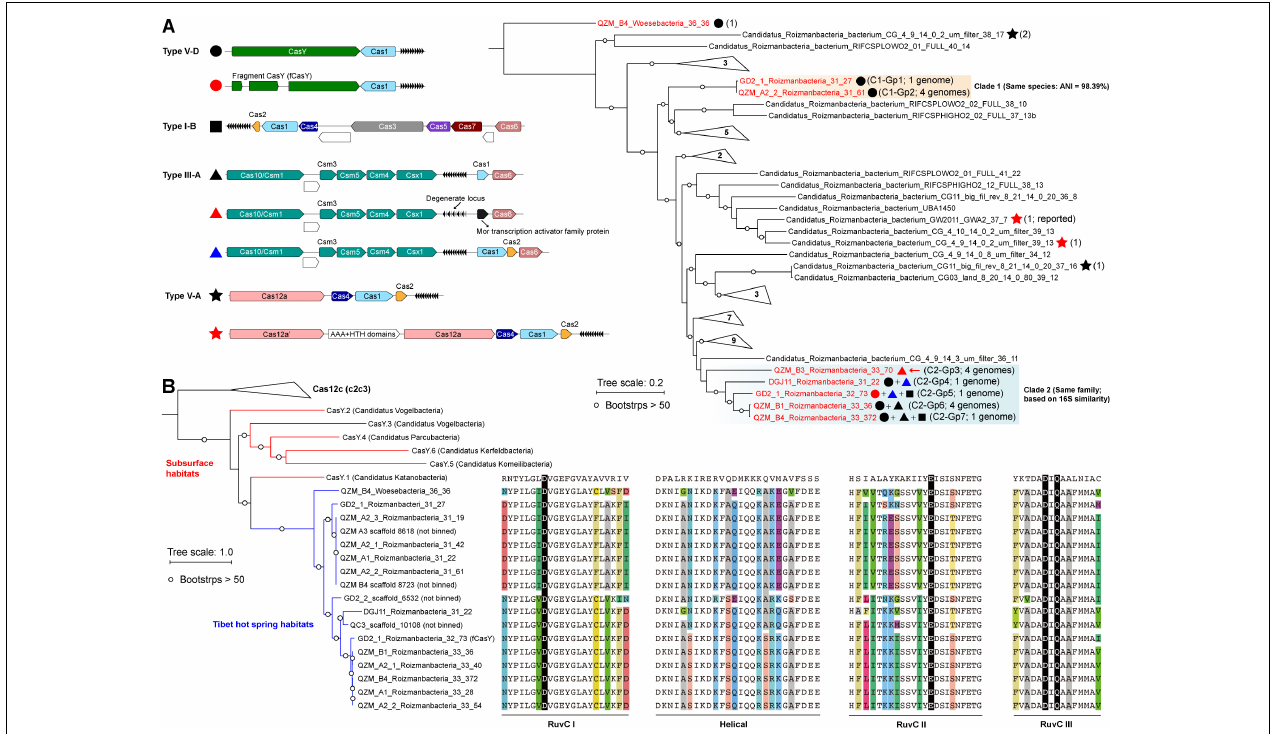
FIGURE 1 | Roizmanbacteria and Woesebacteria genomes encode CRISPR-CasY and/or other CRISPR-Cas systems. (A) CRISPR systems detected in genomes of CPR bacteria (top left), the phylogenetic classification of which was established based on concatenated sequences of 16 ribosomal proteins (top right). Included in the analyses are the dereplicated representatives of Roizmanbacteria and Woesebacteria genomes from this study (in red) and Roizmanbacteria genomes from NCBI (in black). CRISPR system types in each genome are indicated by the symbols after the genome names, and the number of non-redundant genomes is shown in brackets. Those clades without CRISPR-Cas are collapsed, and the number of genomes are shown (see Supplementary Figure S1 for the uncollapsed tree). The red arrow indicates the presence of a restriction-modification system, the hypothetical proteins are shown in white. (B) Phylogenetic analyses of CasY proteins, including those previously reported and those identified in this study. The local alignment of conserved motifs of CasY protein, including RuvC-I, -II, -III and helical, are shown. The catalytic residues are shown by white letters on a black background; for other residues, backgrounds of different colors are used if the amino acids are inconsistent among those CasY identified in this